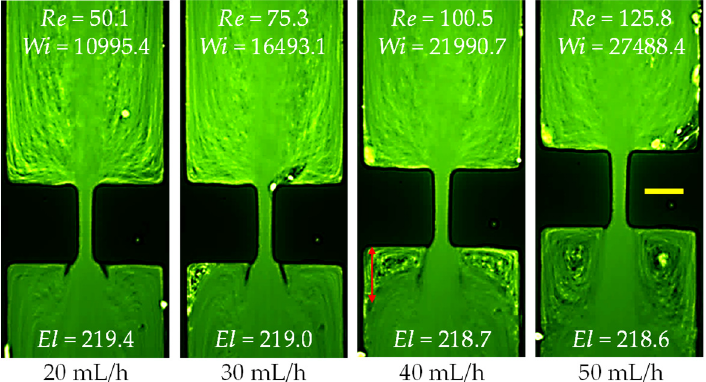
Figure 9. Strongly inertial flow (downward) of 200 ppm highly elastic and highly shear thinning PAA solution at the contraction–expansion region of the microchannel. The scale bar represents 100 µm.